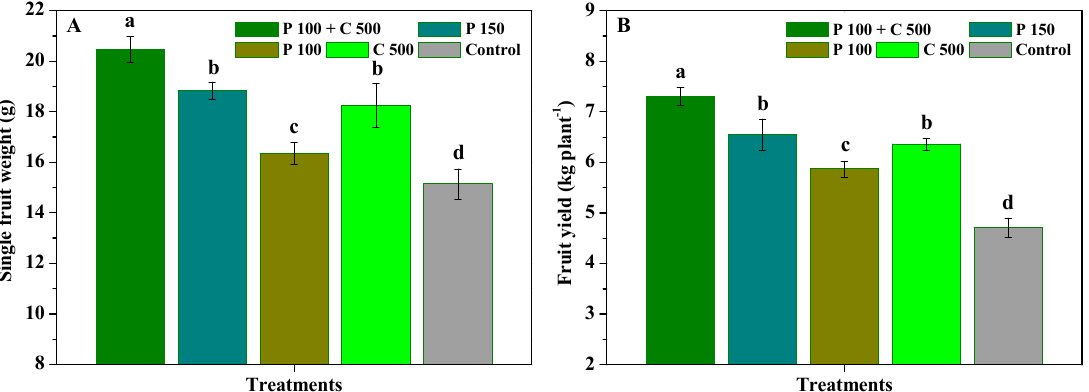
Figure 5. The influence of pyraclostrobin and chitosan on single fruit weight ( A ) and fruit yield per plant ( B ) of R. roxburghii . Error bars indicate the SD of the three replicates. Small letters represent significant differences on a 5% ( p < 0.05) level. Table 3. The influence of pyraclostrobin and chitosan on R. roxburghii quality.